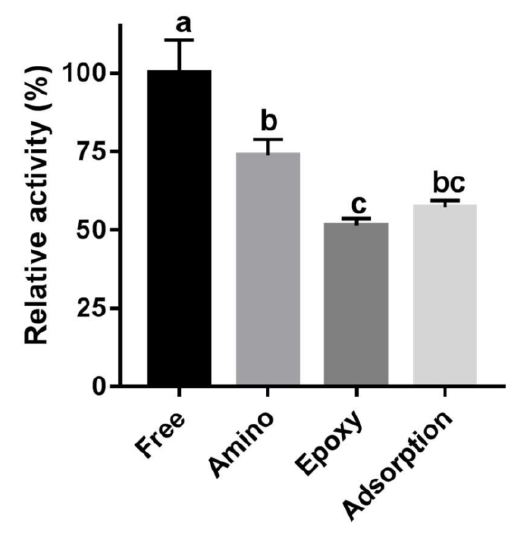
Figure 3. Relative activity of free or immobilized Endo BI-1 (on amino, epoxy, and adsorption resins) on the glycoprotein RNase B. Error bars represent one standard deviation. Means followed by different letters (a, b, and c) are statistically different at p < 0.05.